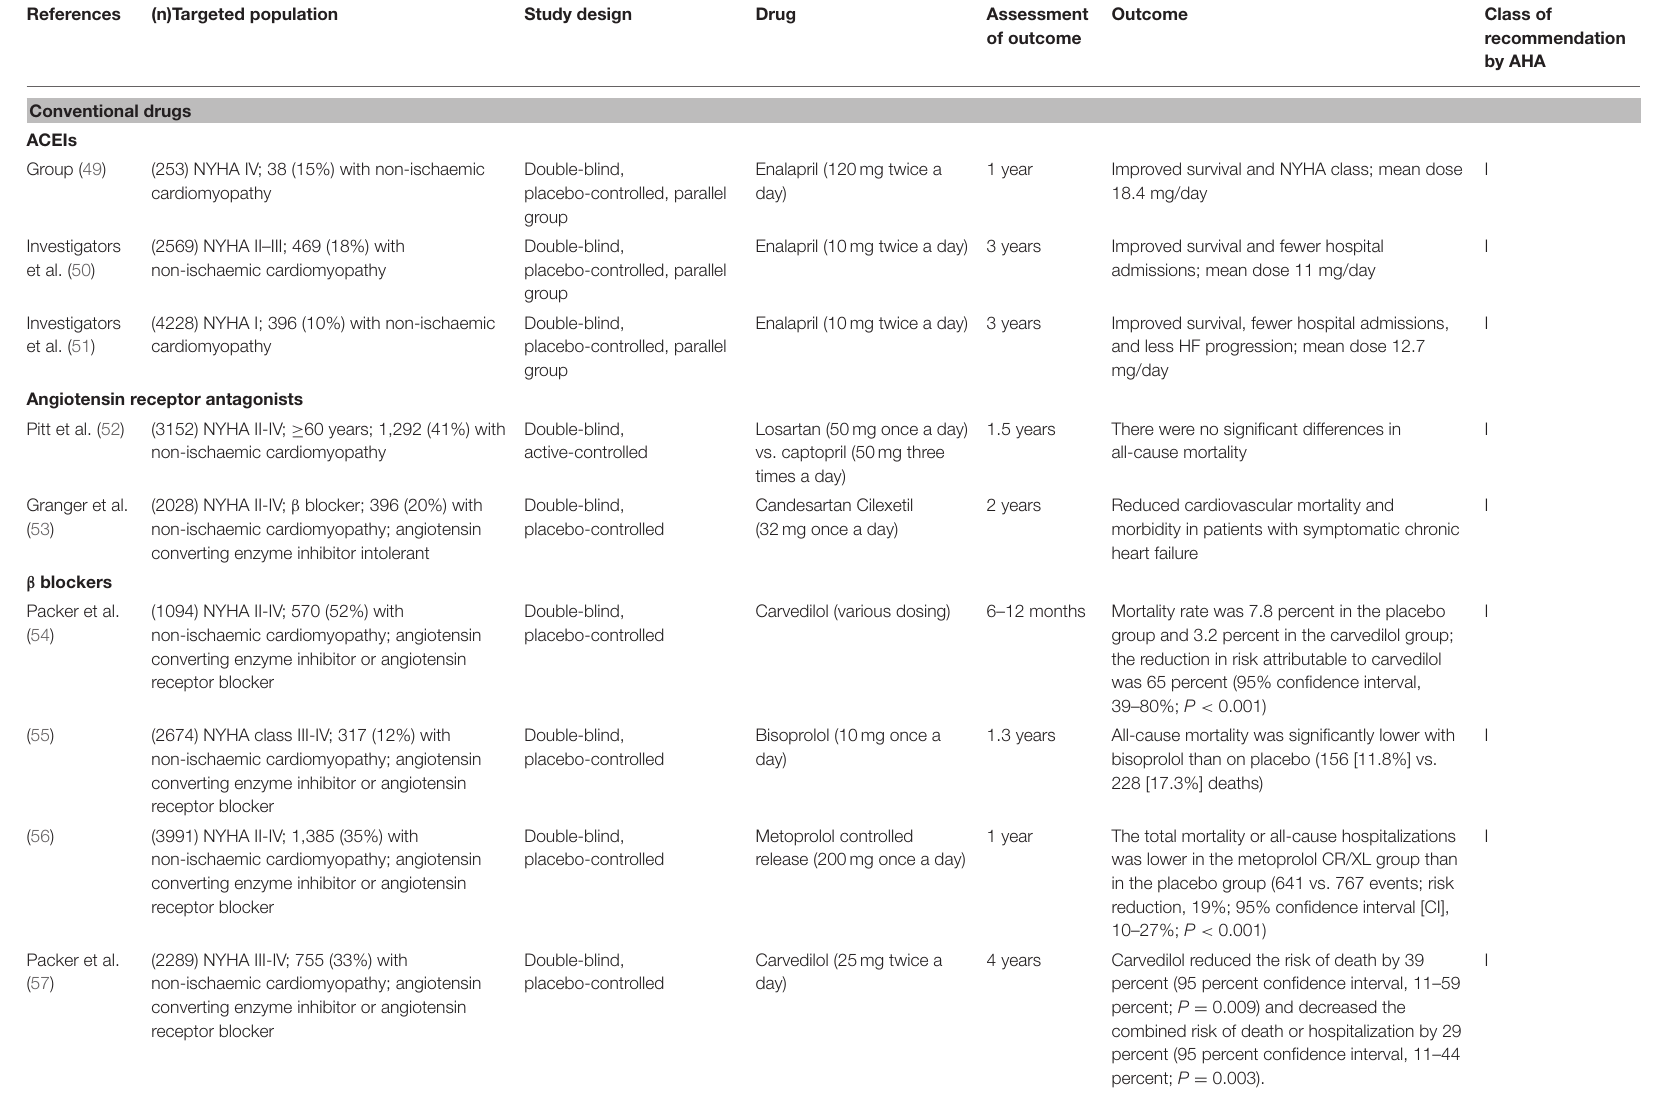
TABLE 2 | Pharmacological treatment of